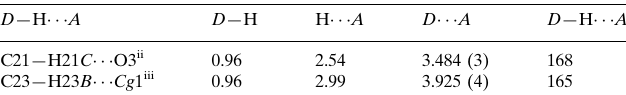
Hydrogen-bond geometry (A˚ , (cid:3)